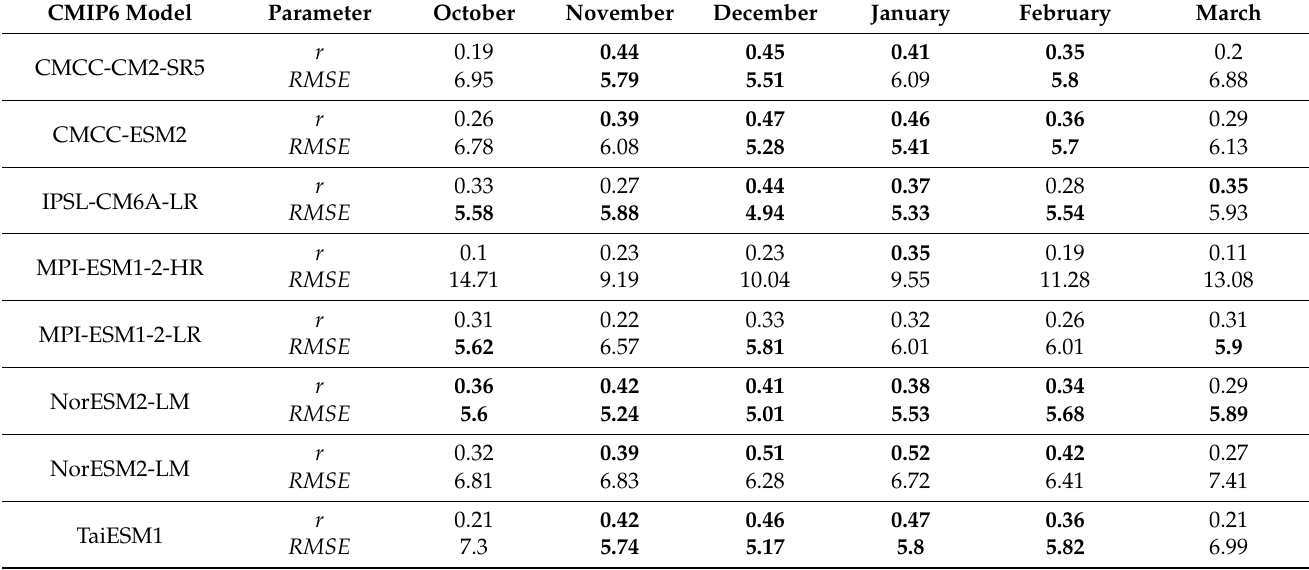
Table 3. Spatial linear correlation coefficient ( r ) and root mean square error ( RMSE ) between the frequency of cyclones over the North Atlantic–European sector in the CMIP6 models and ERA5 reanalysis in the period from 2000 to 2014. The highest (for r ) and lowest (for RMSE ) 30% val- ues of the entire range of the comparison parameters (for both reanalyses and all 12 months) are marked in